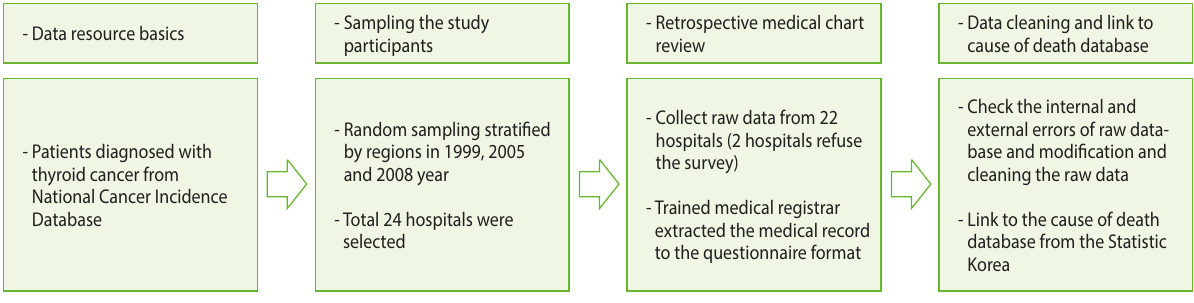
Figure 2. Summary of the National Epidemiologic Survey of Thyroid cancer study